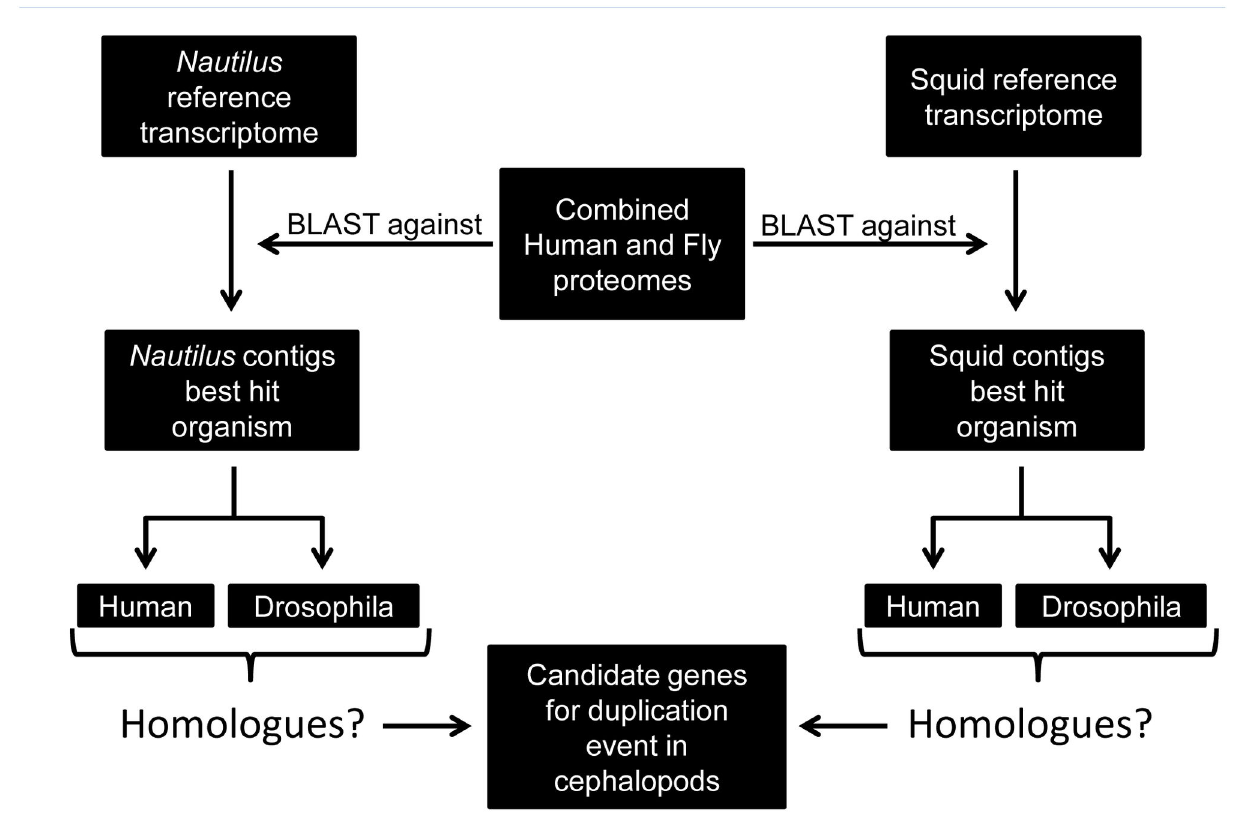
Figure 7. Work flow to find candidate genes that were duplicated and selected for eye evolution in cephalopods. Nautilus and squid transcriptome were compared with a combined Human and Drosophila proteome. Contigs in the Nautilus or squid that shared a homologue gene in Drosophila and Human were further